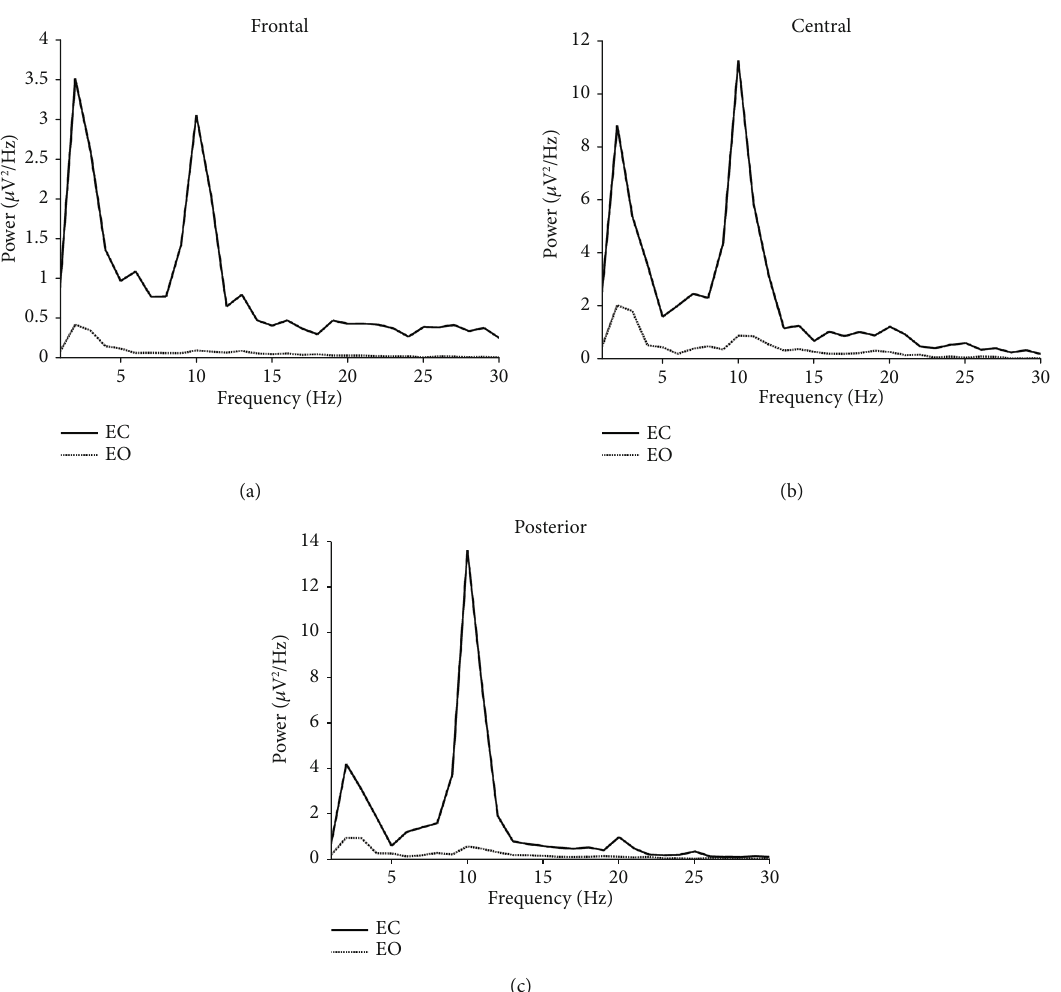
Figure 3: Group-averaged EEG power spectral densities under eyes-closed (EC) and eyes-open (EO) conditions in (a) frontal, (b) central, and (c) posterior